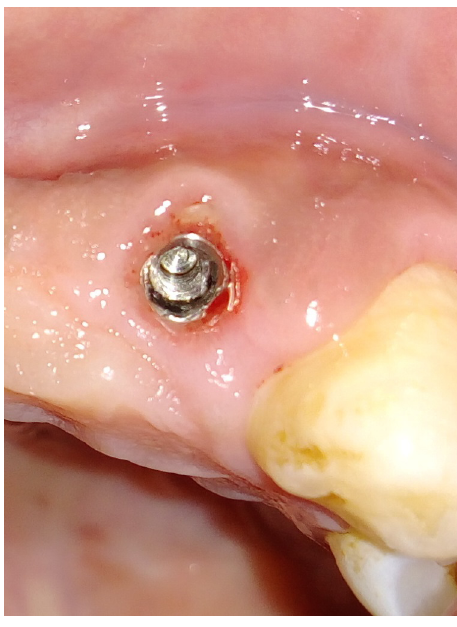
Fig. 8. Showing exposure of shield